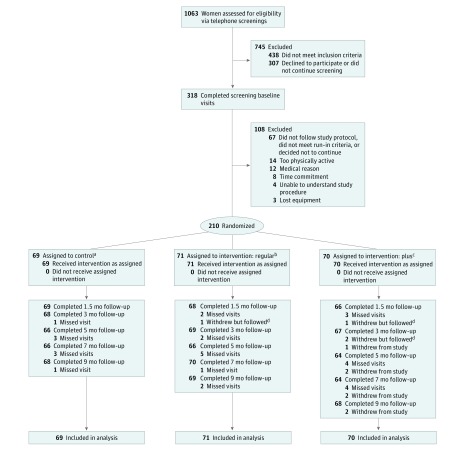
Study Flow DiagramaThe control group used the accelerometer only for 9 months with no intervention.bThe regular group completed the 3-month physical activity intervention and 6-month accelerometer maintenance intervention.cThe plus group completed the 3-month physical activity intervention and 6-month mobile phone diary maintenance intervention with accelerometer.dParticipants were counted as “withdrew but followed” on the day they withdrew. Each follow-up visit after the date of withdrawal, they are included as “completed.”